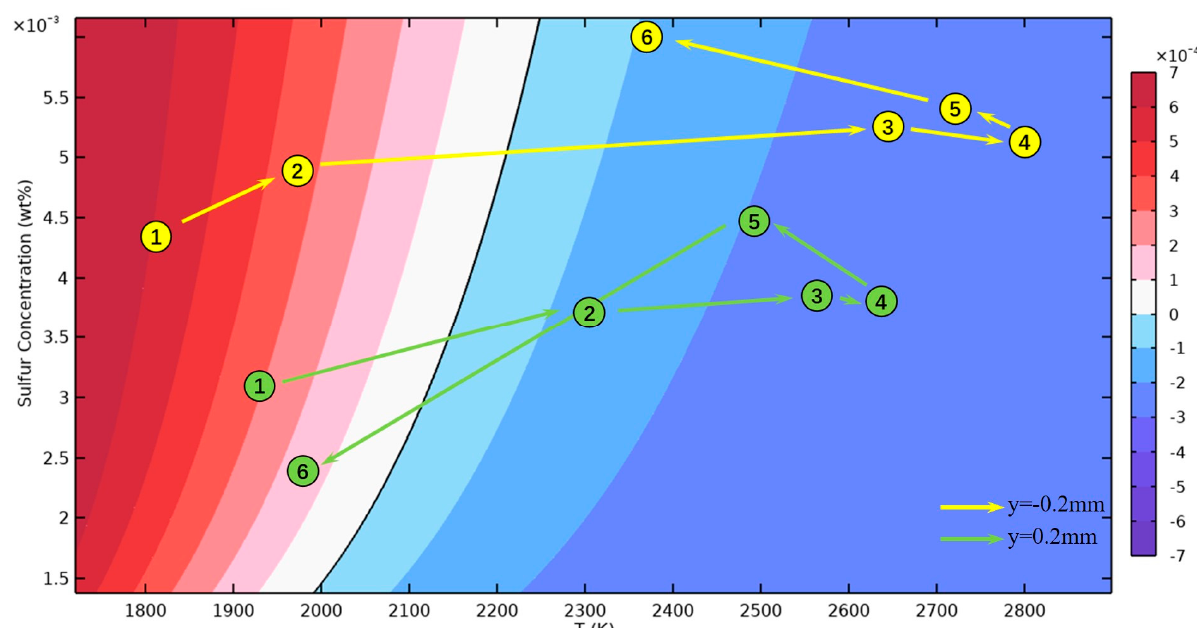
Figure 7. Surface shear stress with x = 1.5 mm at different times. ( A ) 10 ms; ( B ) 20 ms; ( C ) 30 ms; ( D ) 50 ms.